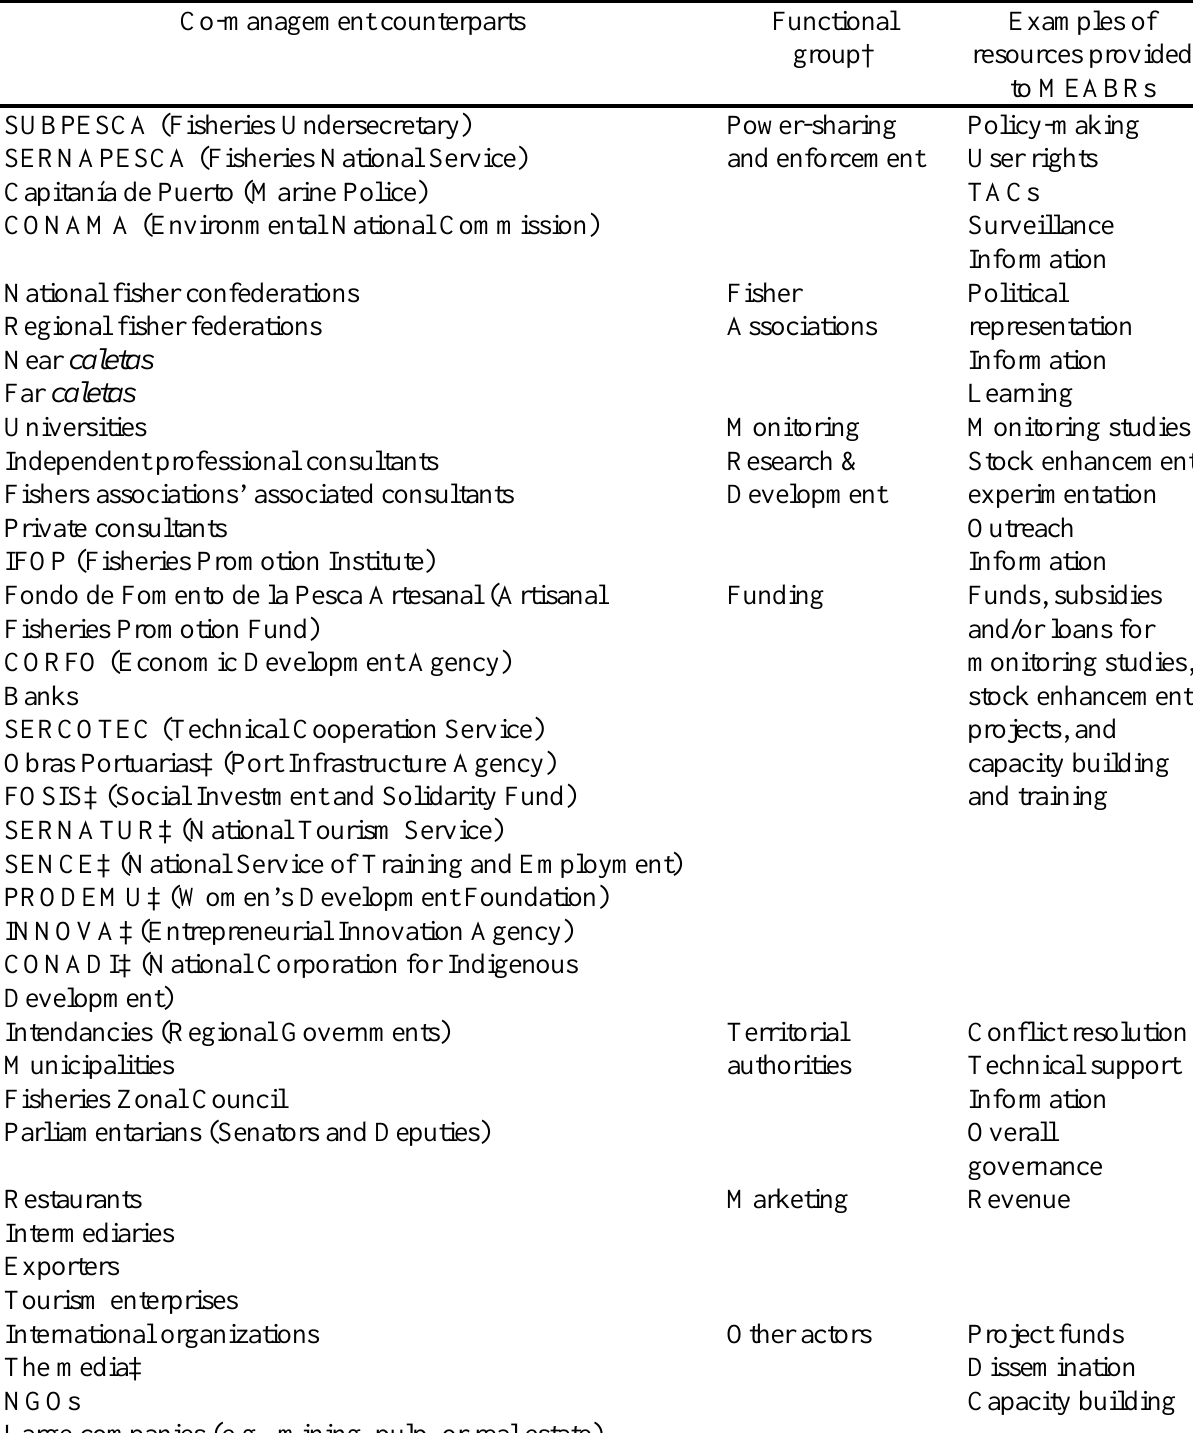
APPENDIX 2: List of actors involved in the Chilean MEABRs system used in